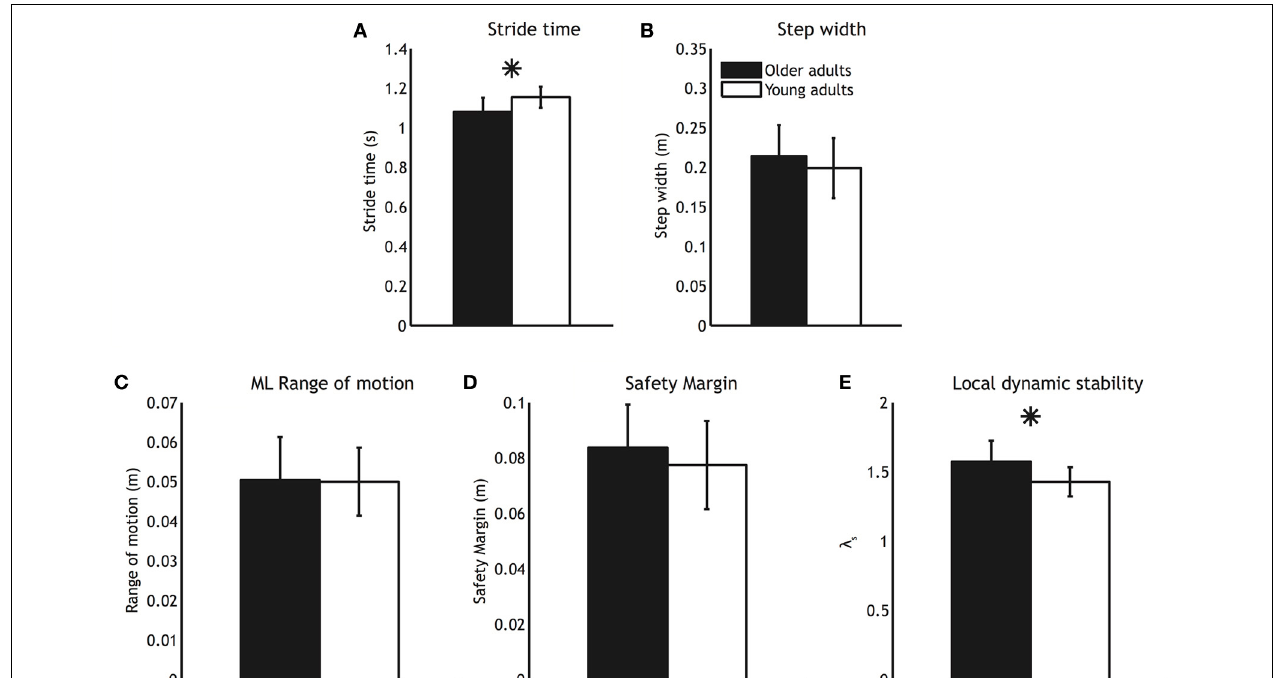
FIGURE 1 | Meangaitparametersforolderadults(blackbars)andyoungeradults(whitebars).(A) Stridetime (B) Stepwidth (C) Medio-lateralCoMrangeof motion (D) Safety margin and (E) Local dynamic stability. Error bars represent standard deviation, and the asterisk represents a significant group